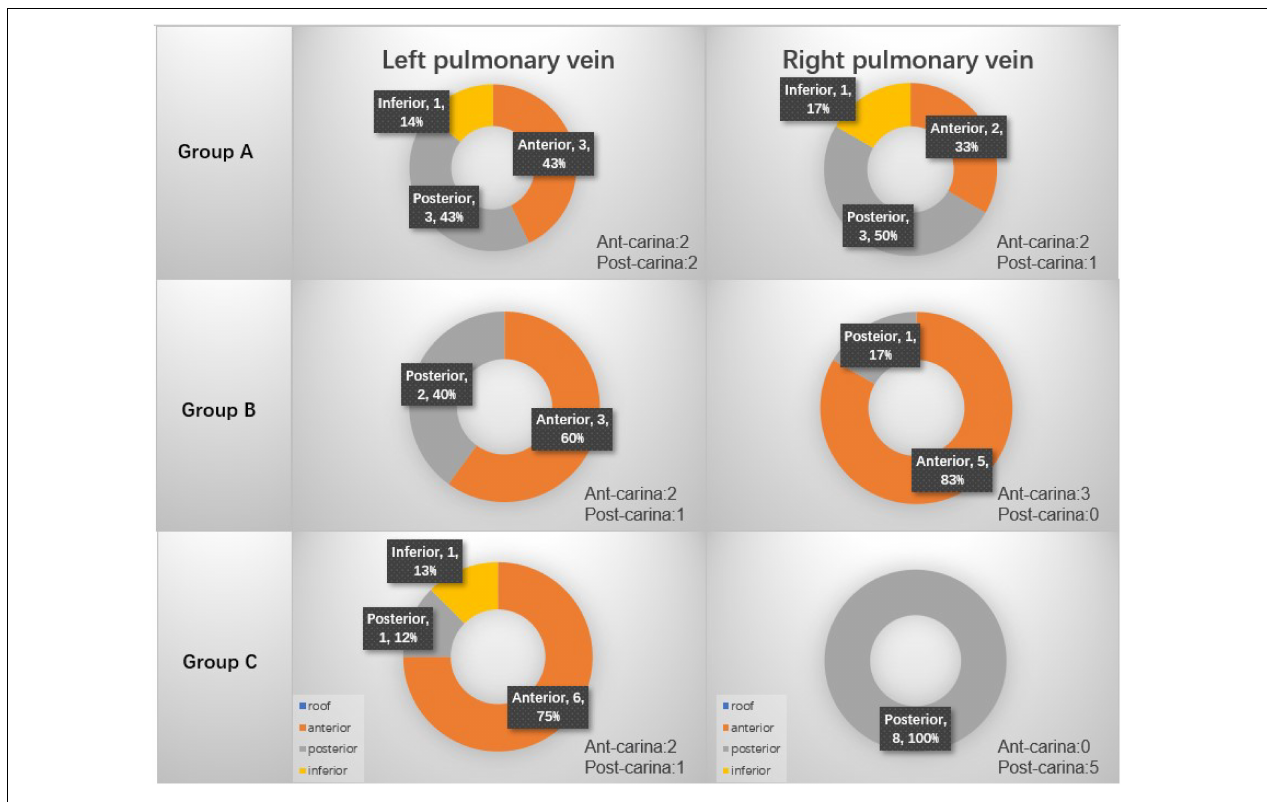
FIGURE 3 | Procedural gap distribution among three groups.